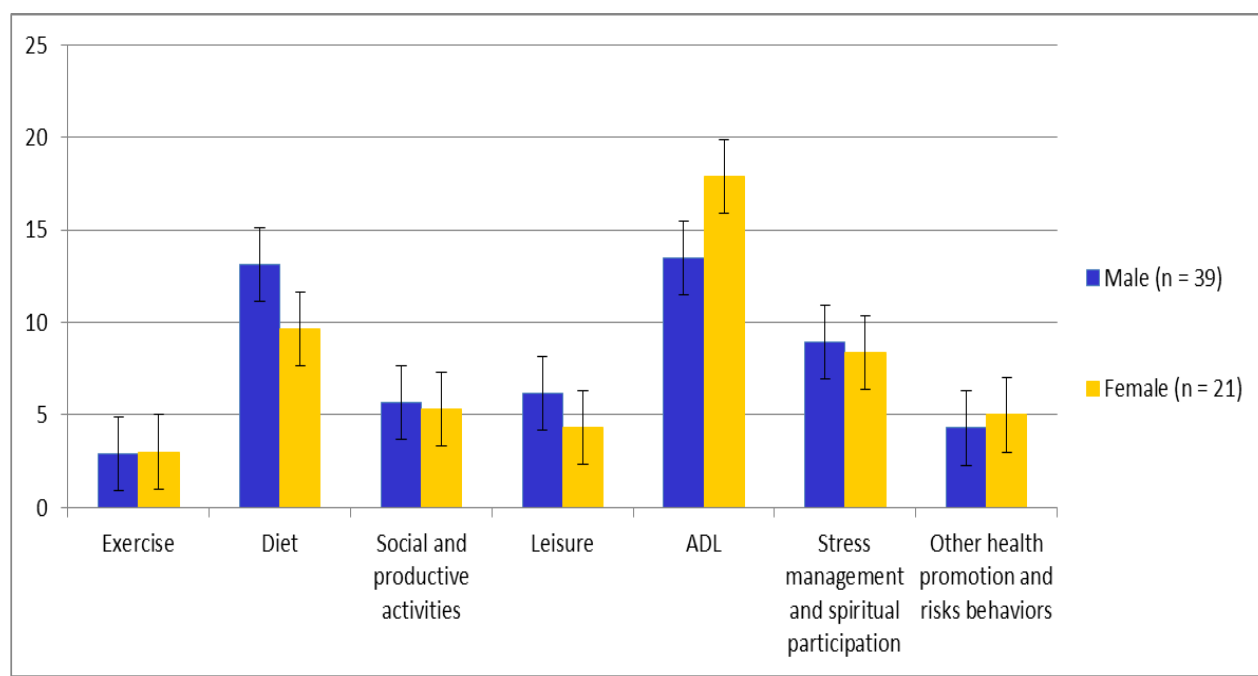
Figure 2. Lifestyle differences between sexes, male ( n = 39) and female and ( n =